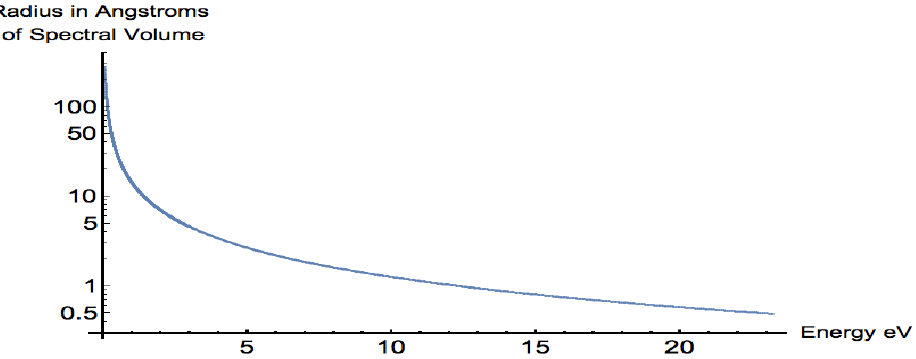
Figure 11. Log of the radius of the spherical spectral volume V 1 ( E ) , as a function of the vacuum field energy E , from 0.05 eV to 23